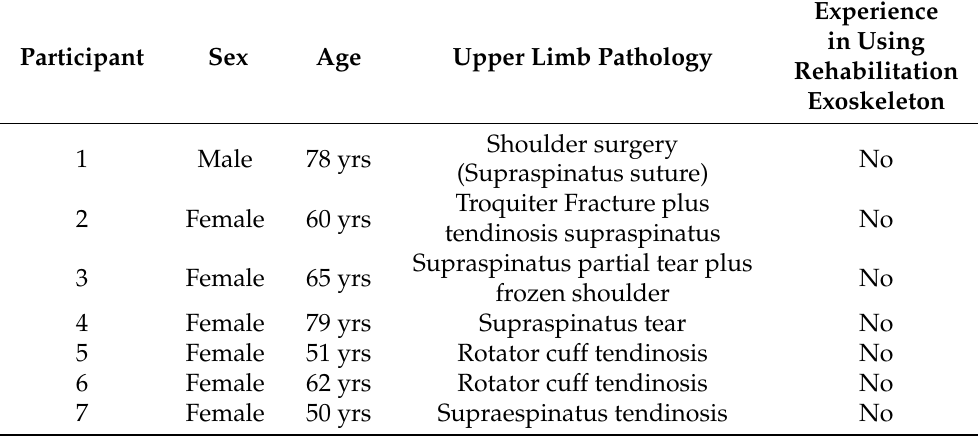
Table 1. Participant